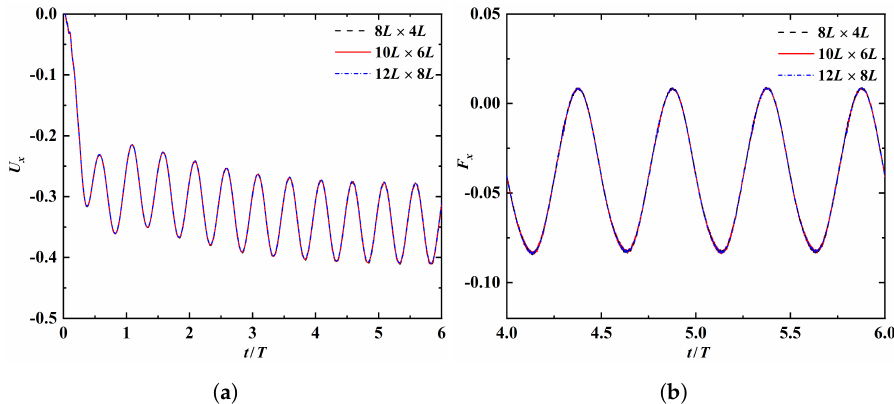
Figure A3. Time histories of ( a ) the leading-edge’s horizontal velocity and ( b ) the horizontal fluid force, obtained by using three computational domains with different